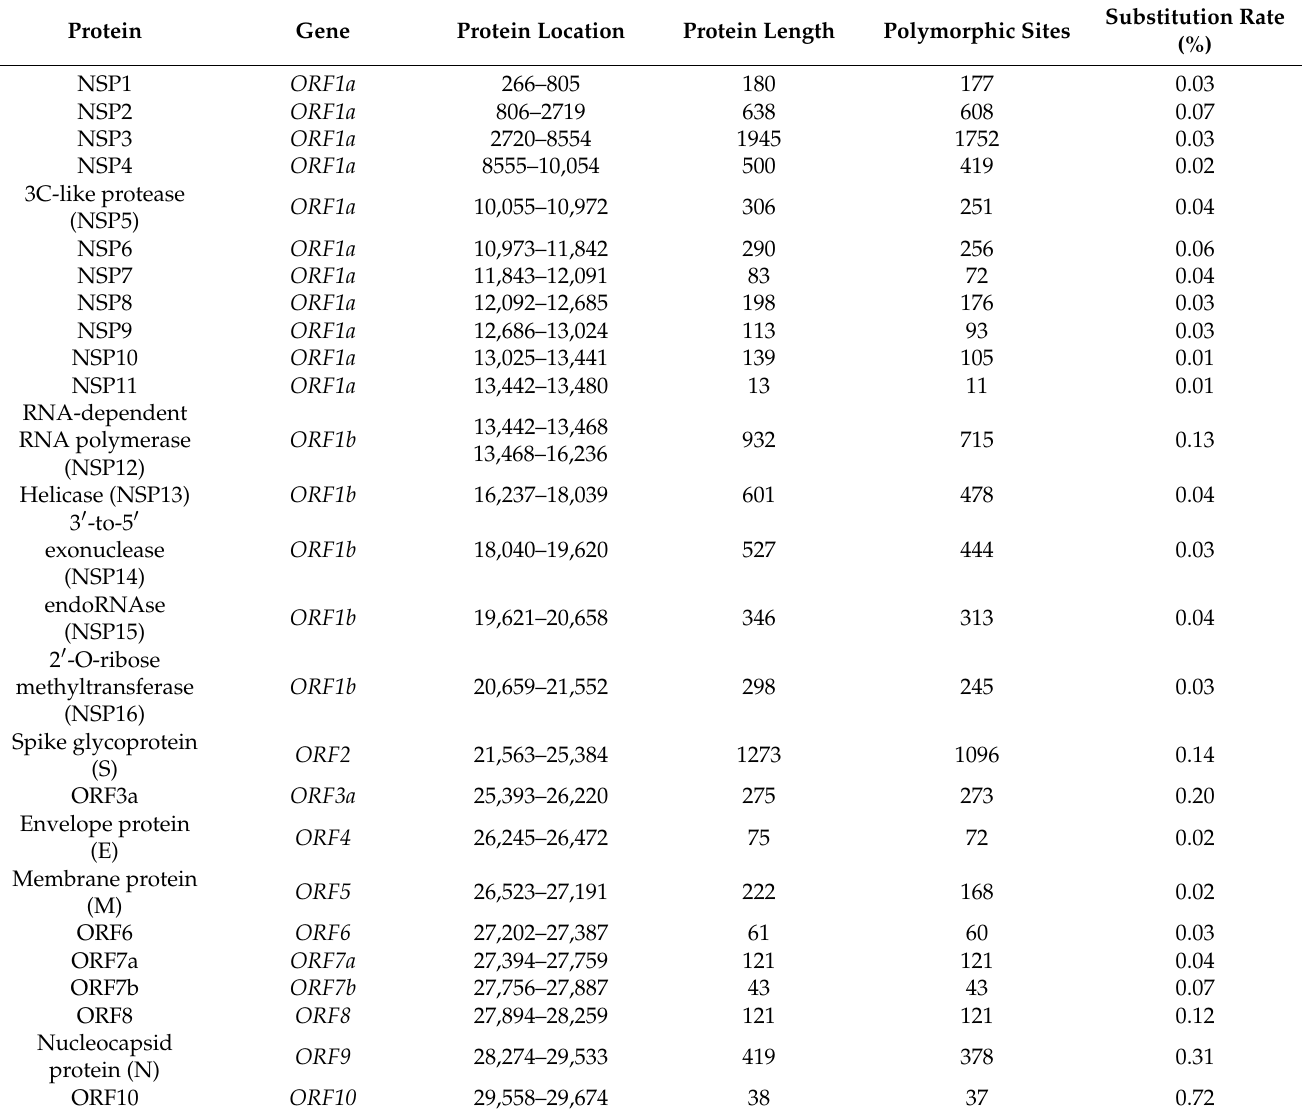
Table 1. Basic characteristics of SARS-CoV-2